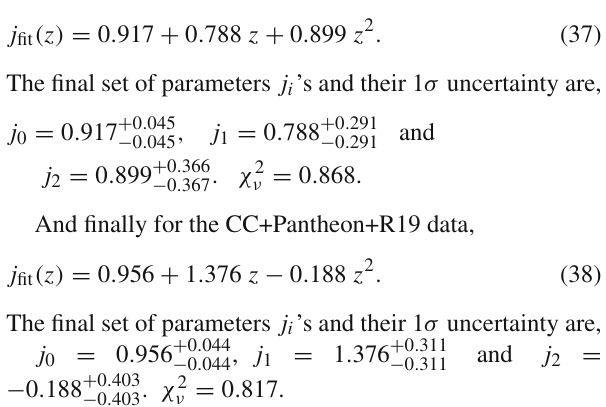
This polynomial is non-linear in z , but it is linear in j i ’s.